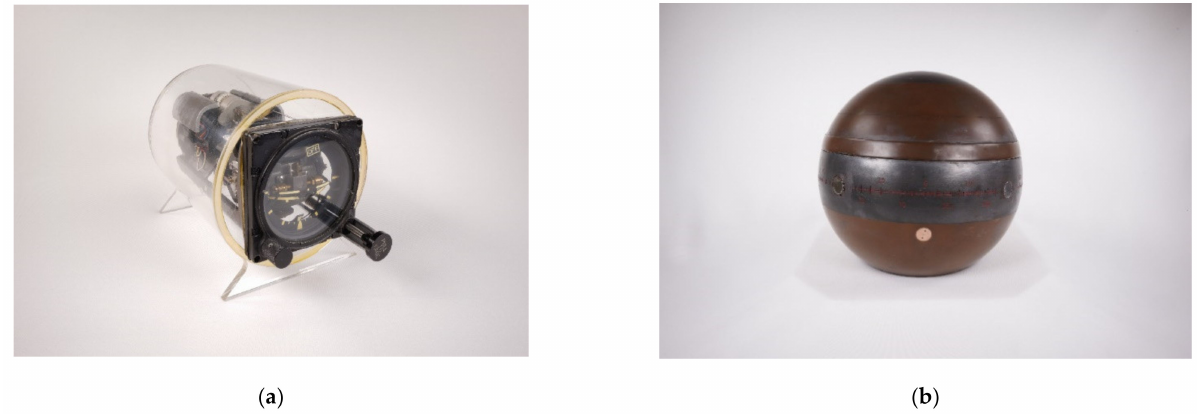
Figure 7. ( a ) Characteristic view of the artificial horizon with a caging device (inventory number KH22-10, Gyrolog, CC-BY-SA). ( b ) Difficult definition of a front view of a ship gyro compass manufactured by Anschuetz (inventory number GO05/01-10, Gyrolog,